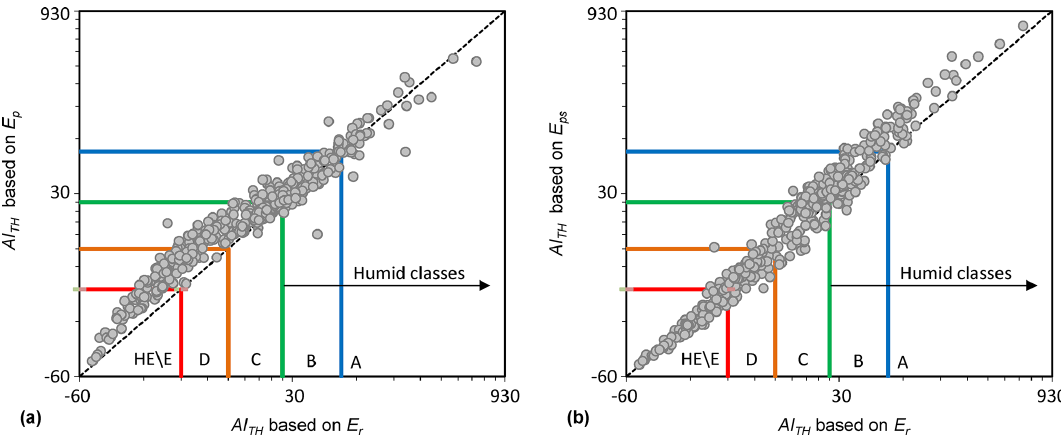
Figure 6. (a) The 1:1 log-log plots of AI TH using mean monthly E p versus AI TH using mean monthly E r and (b) AI TH using mean monthly E ps versus mean monthly AI TH using the data of all 525 stations from the three databases CIMIS, AGBM, and